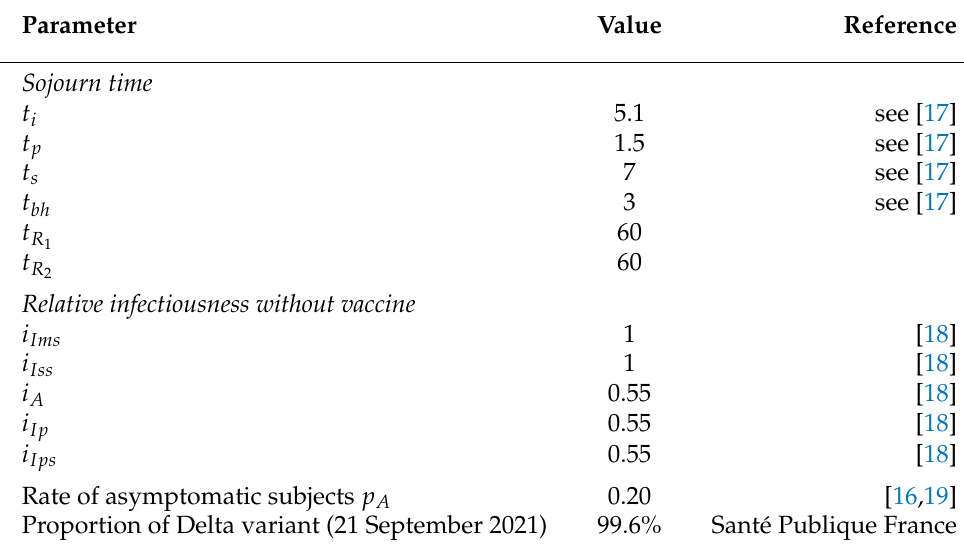
Table 1. The model parameters as extracted from the literature (extended from [10]).